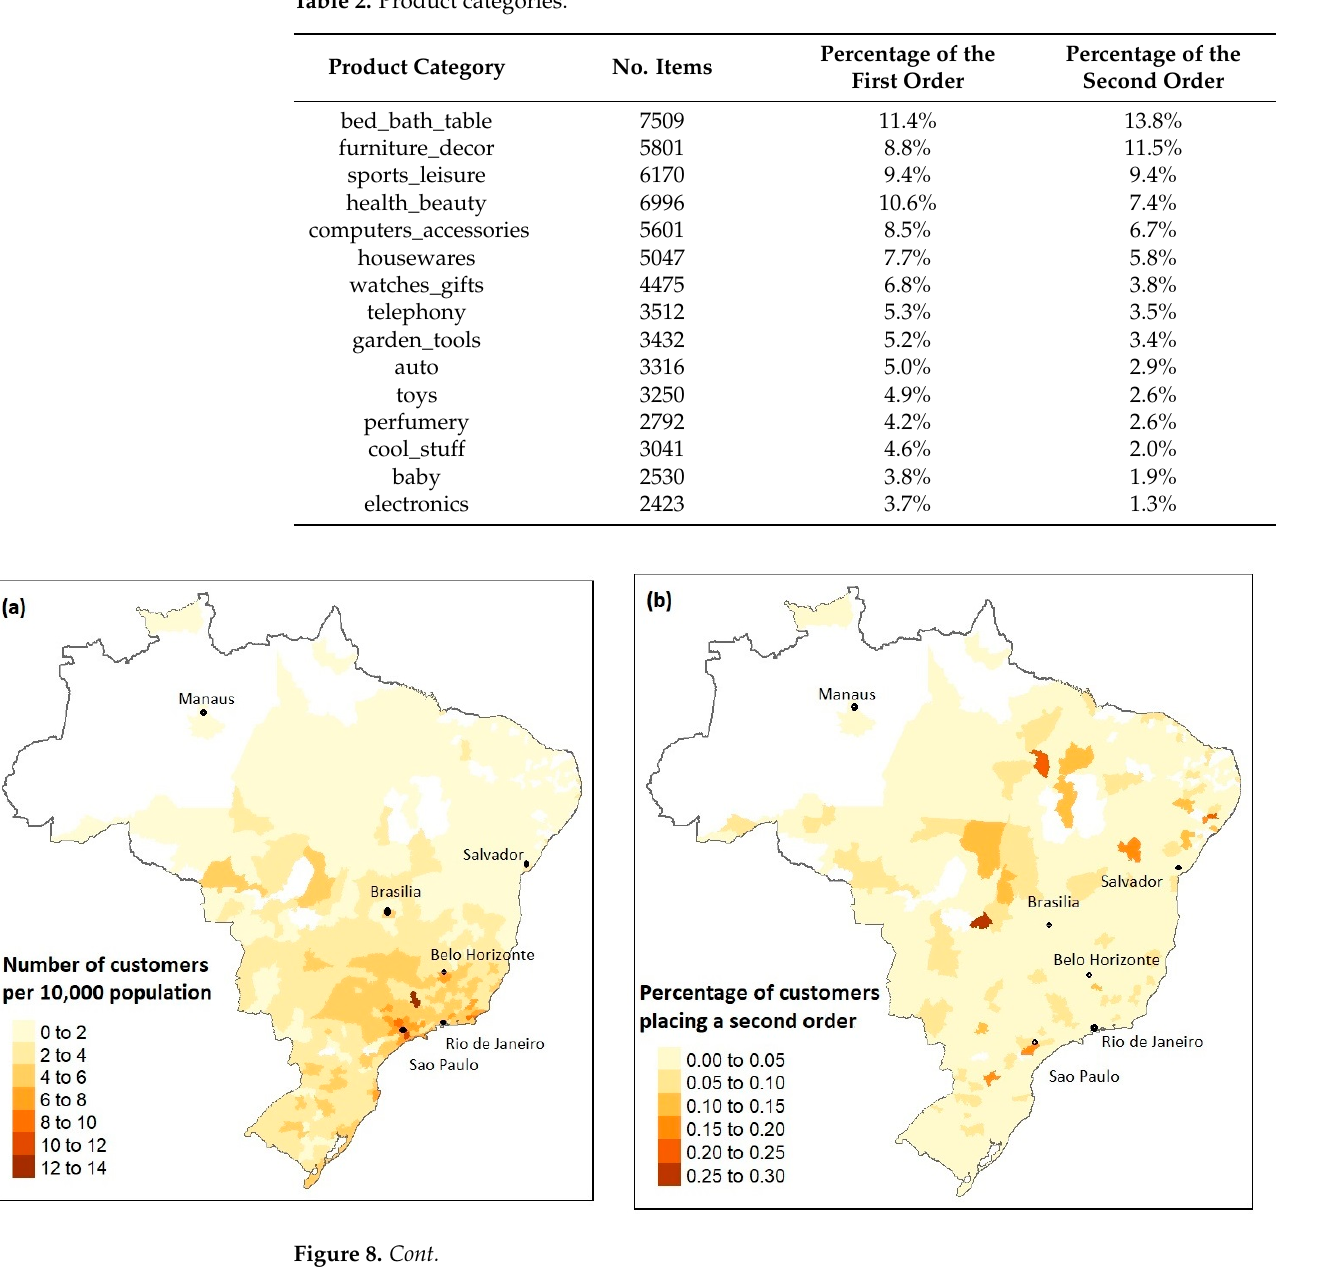
Table 2. Product categories.